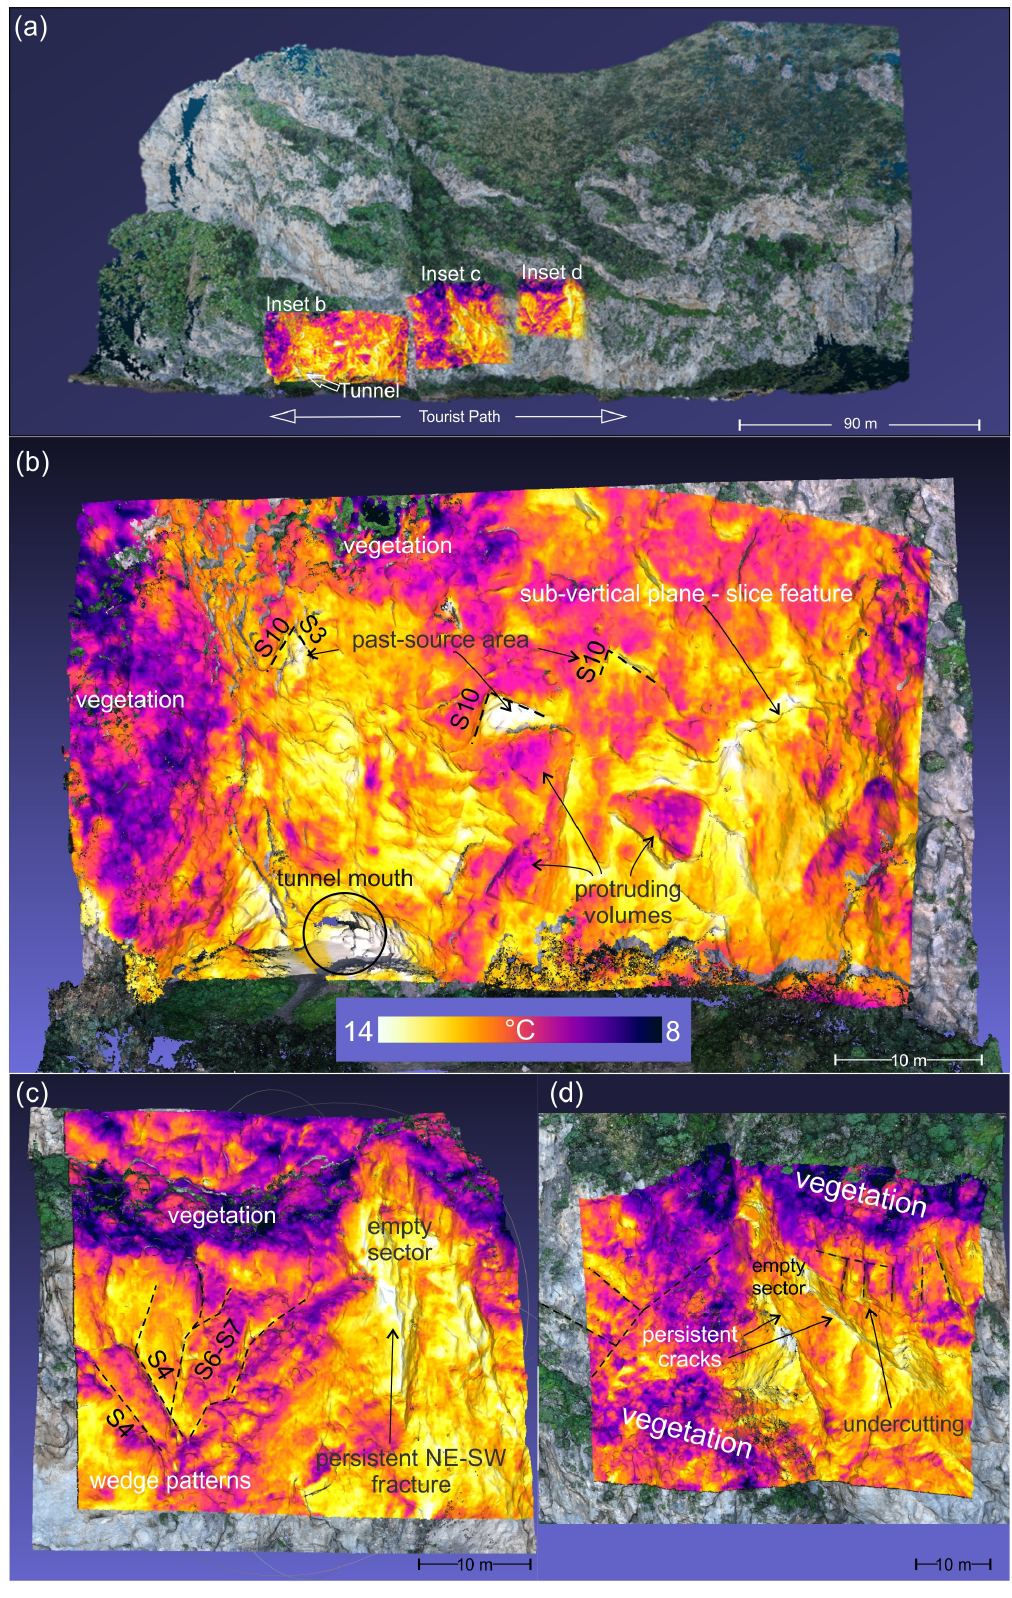
Figure 6. ( a ) location of the rock mass sectors framed by IRT surveys; ( b – d ) thermal images over- lapped with the slope digital model showing the most relevant surface temperature variations related to specific morphological and structural rock mass features.